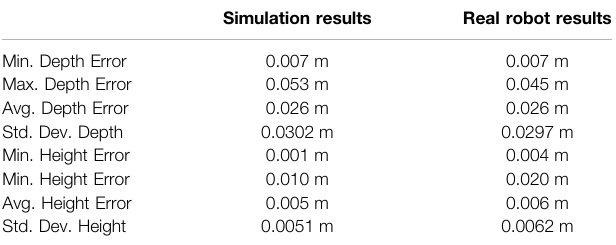
TABLE 1 | Statistical results of the estimate of the obstacle dimensions in both simulation and on the real robot. The data were extracted considering rectangular obstacles of different dimensions, placed at different distance and orientation with respect to the